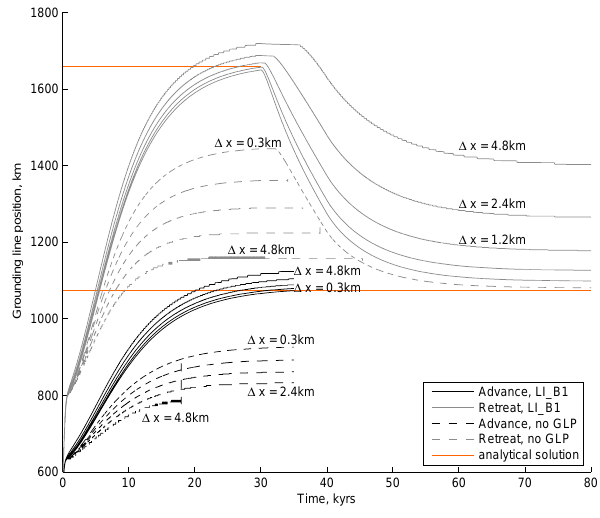
Fig. 2. Time evolution of grounding line position for the LI B1 GLP (solid lines, see Table 1) and for the no-GLP case (dashed lines). Results at the five different resolution levels (from 1x = 4 . 8km to 1x = 0 . 3km) are shown for both advance (black) and retreat (grey) simulations. The horizontal orange lines indicate the analytical (Schoof, 2007a) steady state grounding line position for the first phase of the retreat simulations (shorter line) and for all other cases (longer